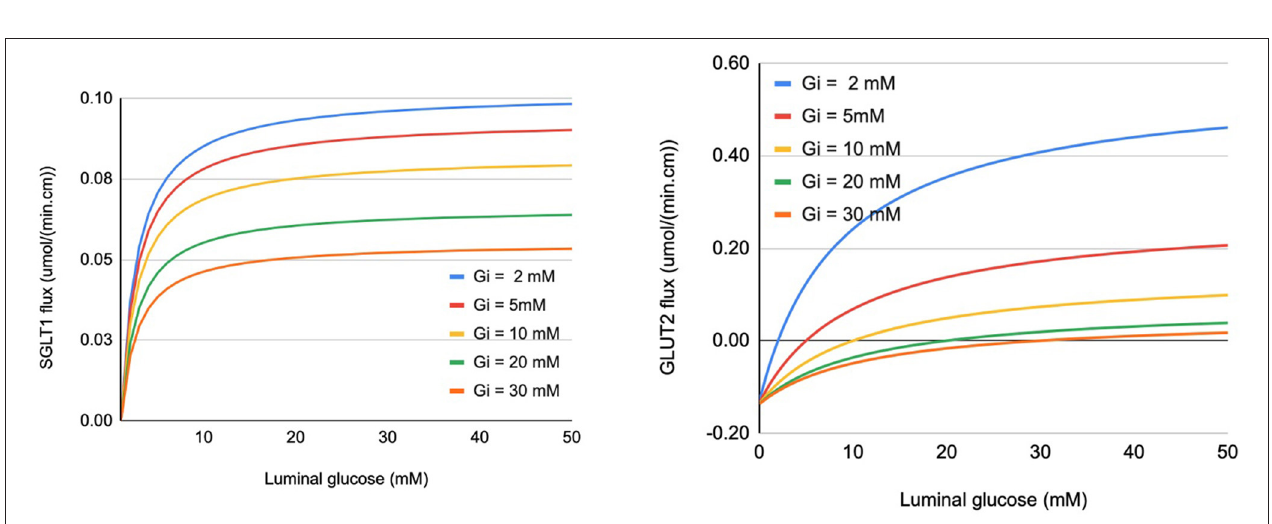
FIGURE 2 | Glucose flux through SGLT1 (left panel) and apical GLUT2 (right panel) under varying conditions of luminal and intracellular glucose (Gi). Fluxes are expressed per cm of intestinal length using parameters specified in section 2.3. in Figure 2 . The SGLT1 flux was calculated with constant values was used for GLUT2 with parameter values from Lowe and of the apical membrane potential ( − 65 mV) and luminal sodium Walmsley (1986). Glucose flux through the transporters for a (150 mM). Varying these values had minimal impact on the range of extra- and intracellular glucose concentrations is shown